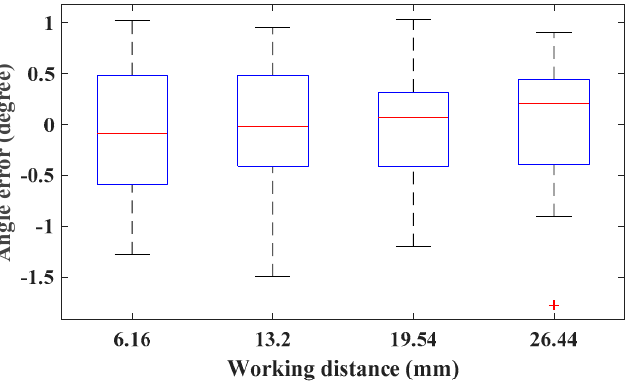
Figure 11. Boxplot of angle estimation error computed from set 3.